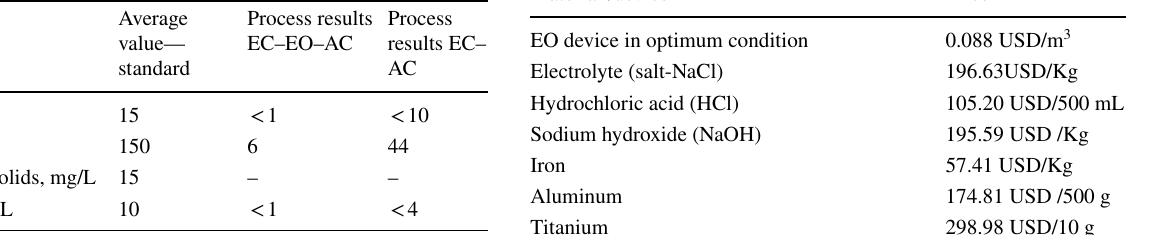
Table 9 Comparison of the process results using EC–EO–AC with the standard followed for irrigation water